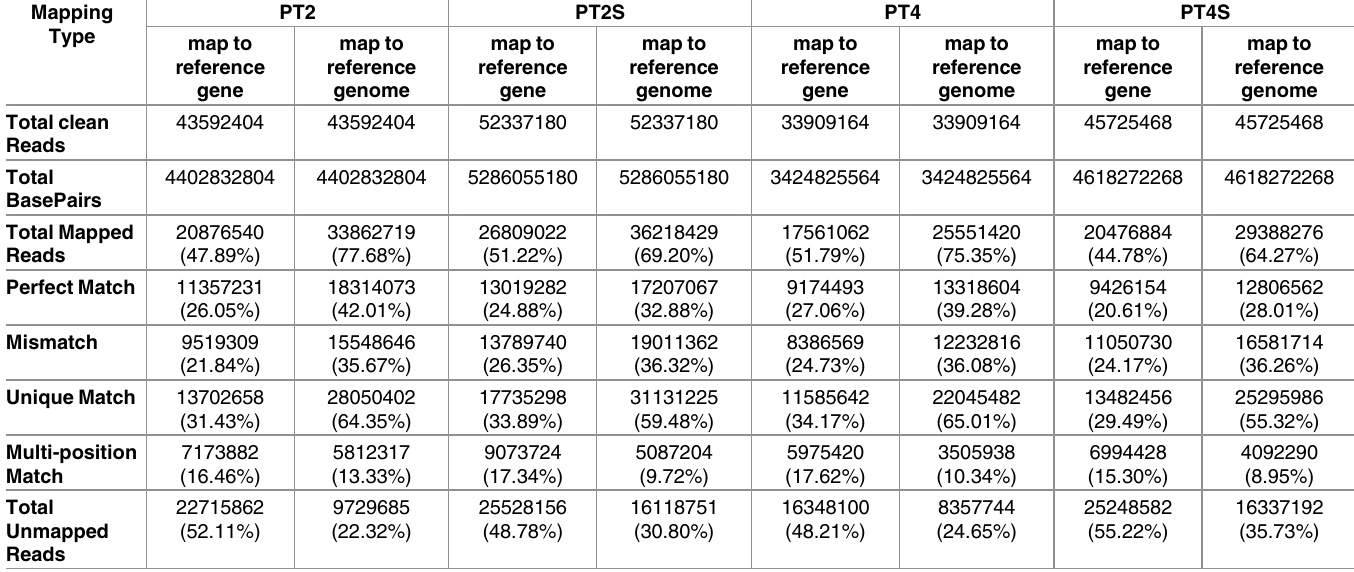
Table 2. Statistics of alignment (map to referencegene and genome) from the four libraries (exposed to salt stressfor 15 days). Mapping Type